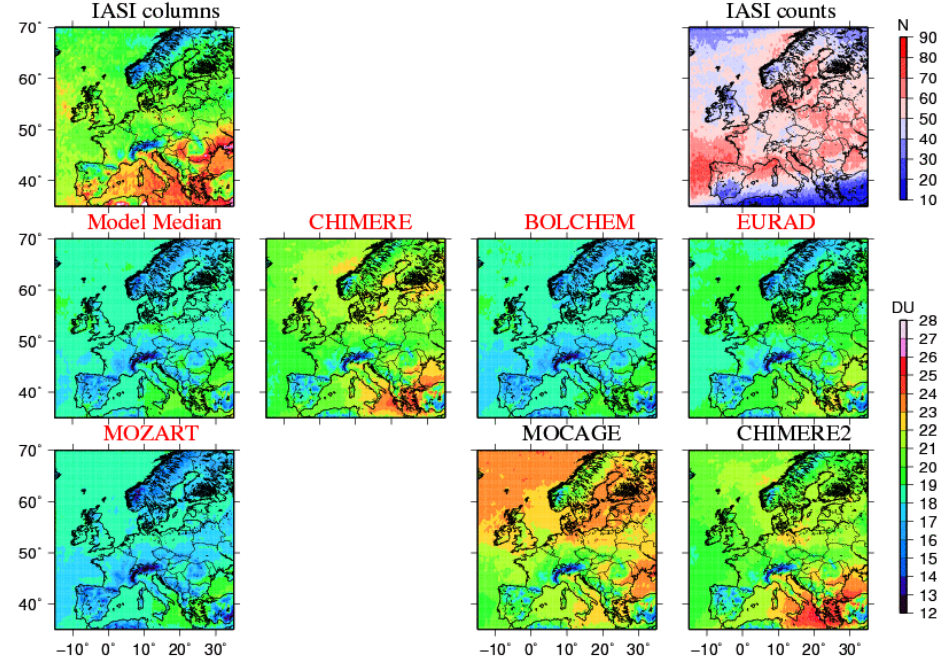
Fig. 4. 0–6km smoothed ozone partial columns (in Dobson Unit) averaged over the summer 2008 (JJA). The IASI columns are calculated from observations corresponding to the morning passage of the satellite. The “IASI counts” map indicates the number of (non cloudy) measurement days available during the